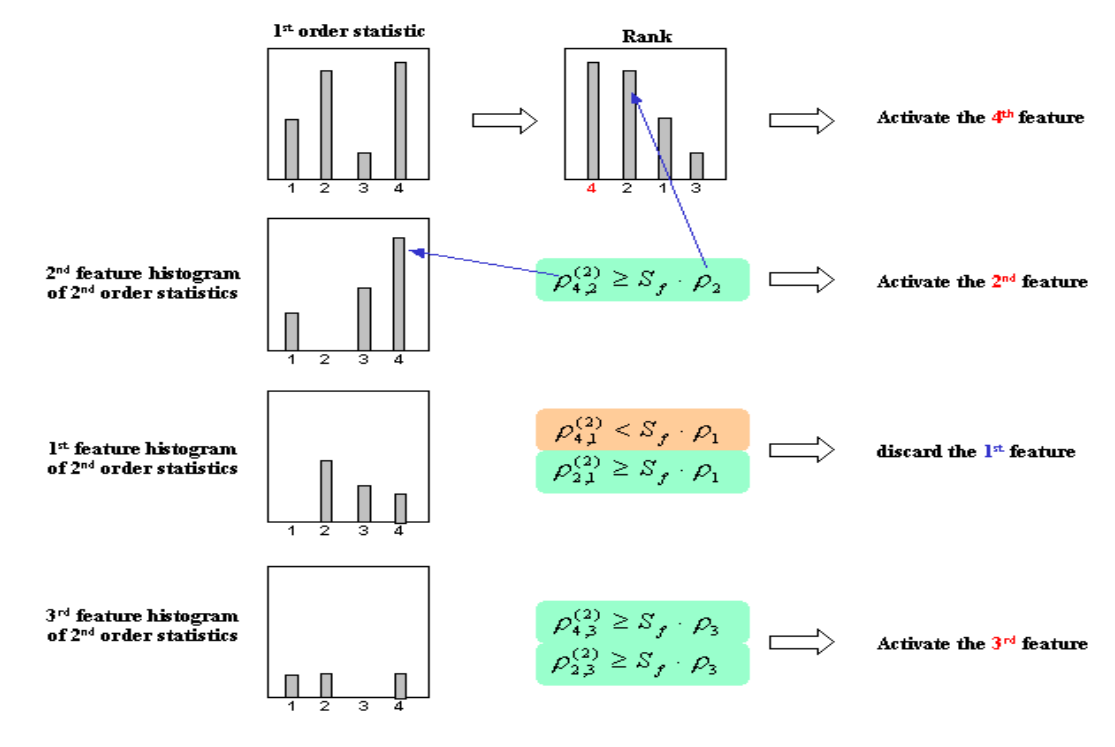
Figure 22. The evaluating procedure of NFL